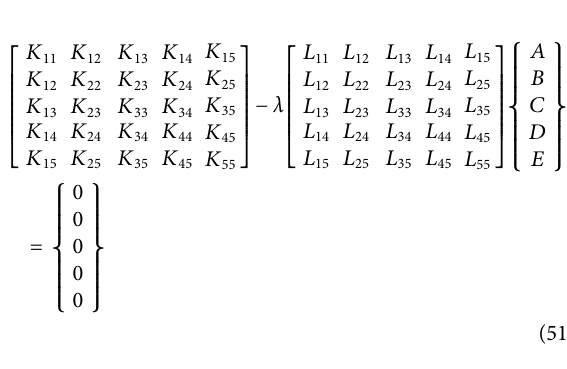
Here A , B , C , D, and E are the buckling amplitude coef fi cients and (cid:1) m (cid:2) m π l , where m is the number of half-waves in the longitudinal direction and n is the number of full waves in the circumferential direction (Wei et al., 2019). By inserting the relations of solutions mentioned above in the stability Equations 45 – 49, the fi nal Equation is obtained in the matrix form as